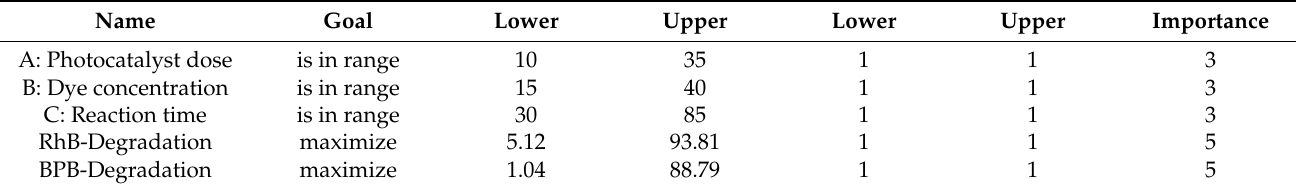
Table 5. Optimization of the individual responses (di) to find the overall desirability response